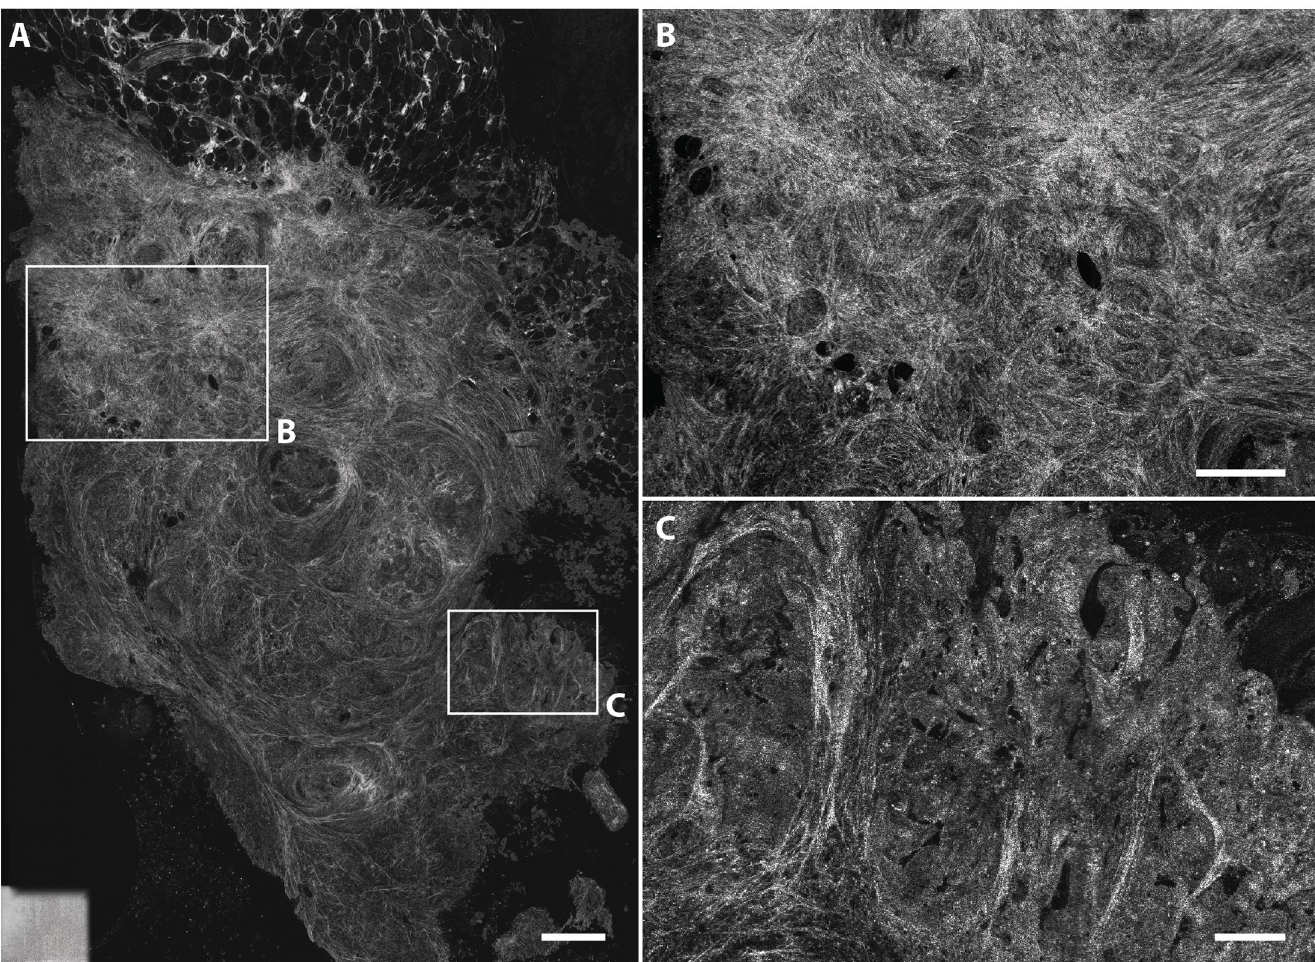
Fig 4. Example FF-OCT image of a well differentiated pancreatic ductal adenocarcinoma. A shows a n overview. B shows a magnifiedview of stromal disorganization, and C shows nests of tumor cells. Scale bars, 2 mm (A), 1 mm (B), and 500 μ m (C).